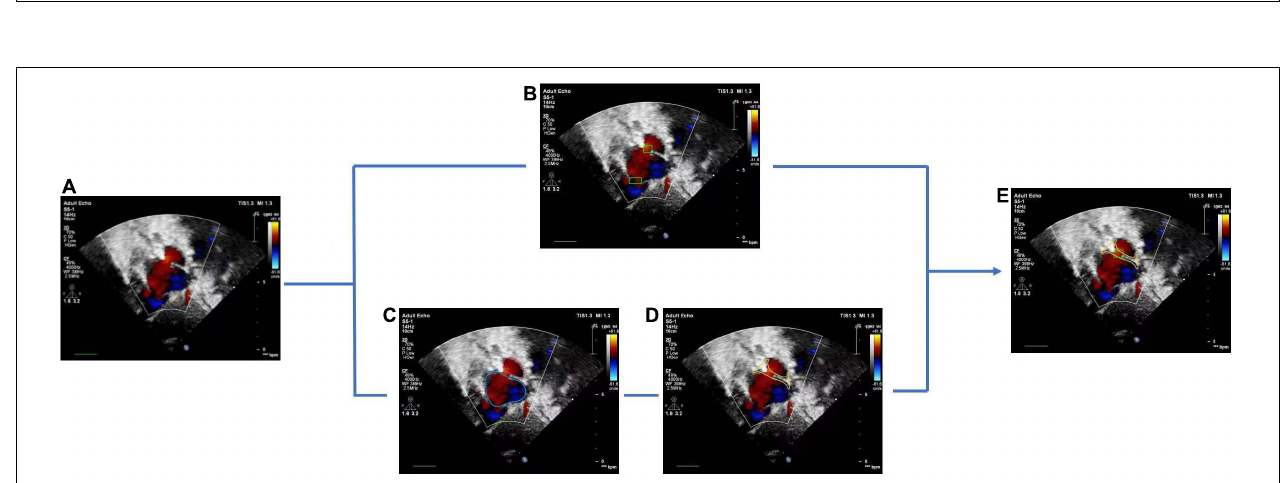
FIGURE 6 | Atrial septal defect detection refinement. (A) Input image with a target view, (B) detected ASD candidates, (C) segmentation result of cardiac anatomy, (D) extraction of atrial septal region based on (C) , (E) final refined result of ASD detection.